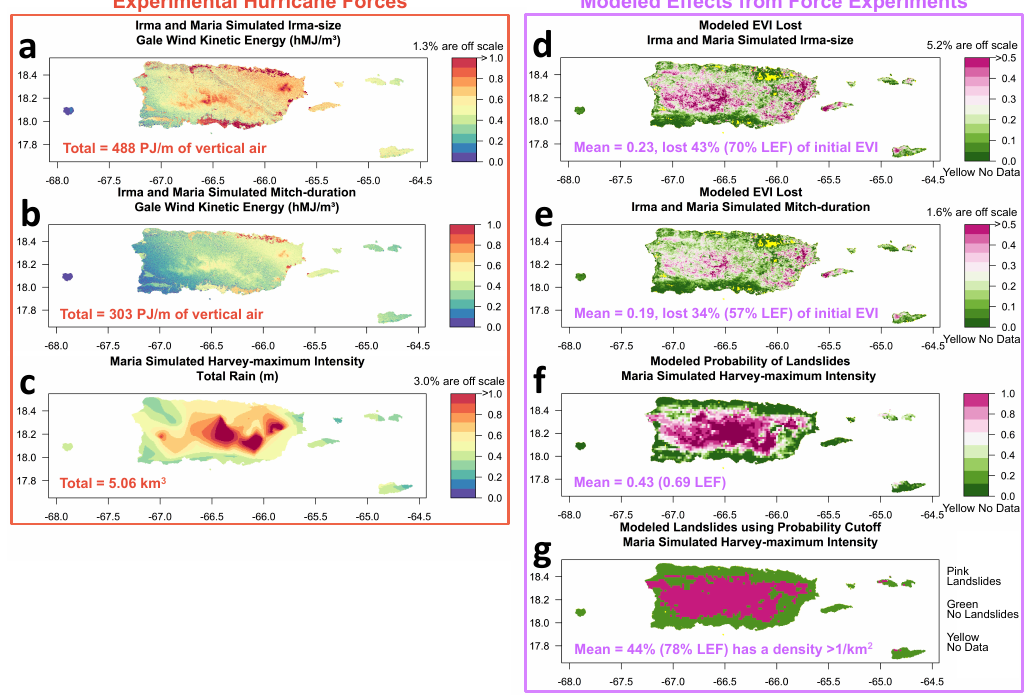
Figure 3. Experiments for future scenarios using past parameters of hurricane forces; altered forces, and resulting modeled effects. Plots of forces that were altered ( a – c ) list magnitude values and modeled effects plots ( d – g ) list mean regional values along with the Luquillo Experimental Forest (LEF) means. The cutoff probability of landslide occurring was set at 0.53 (plot f to g ). In plots ( a , b ), 100 megajoules (hMJ) is 10 8 J and a petajoule (PJ) is 10 15 J.